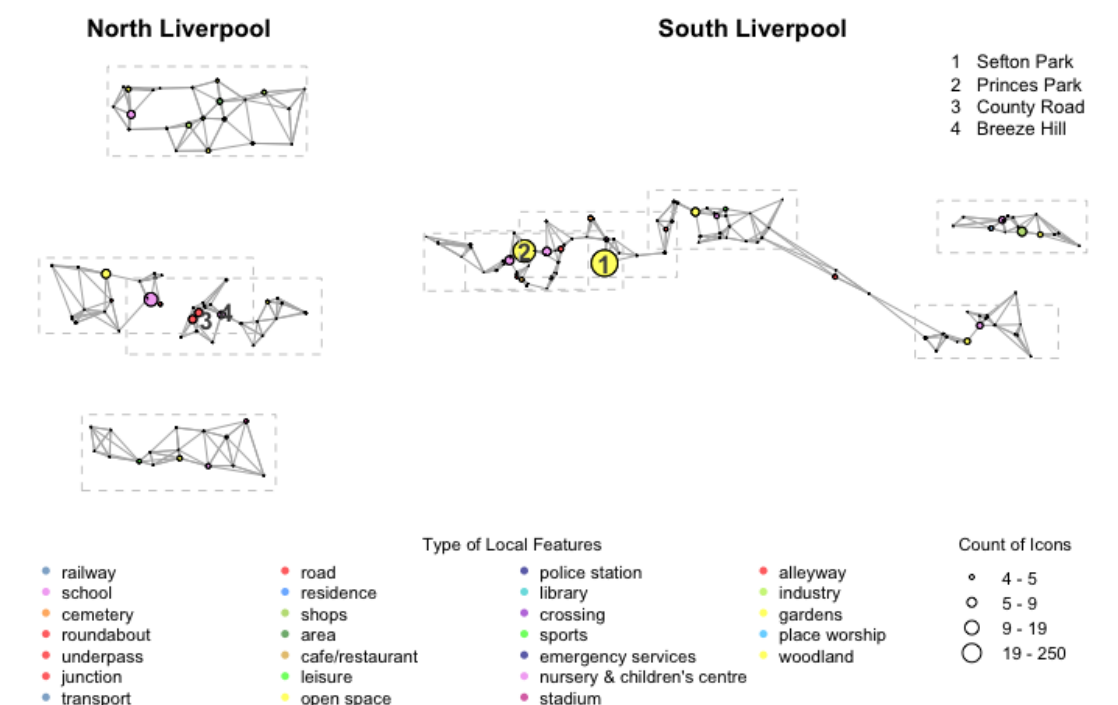
Figure 7. K-nearest neighbour graphs of the Liverpool group of sampled